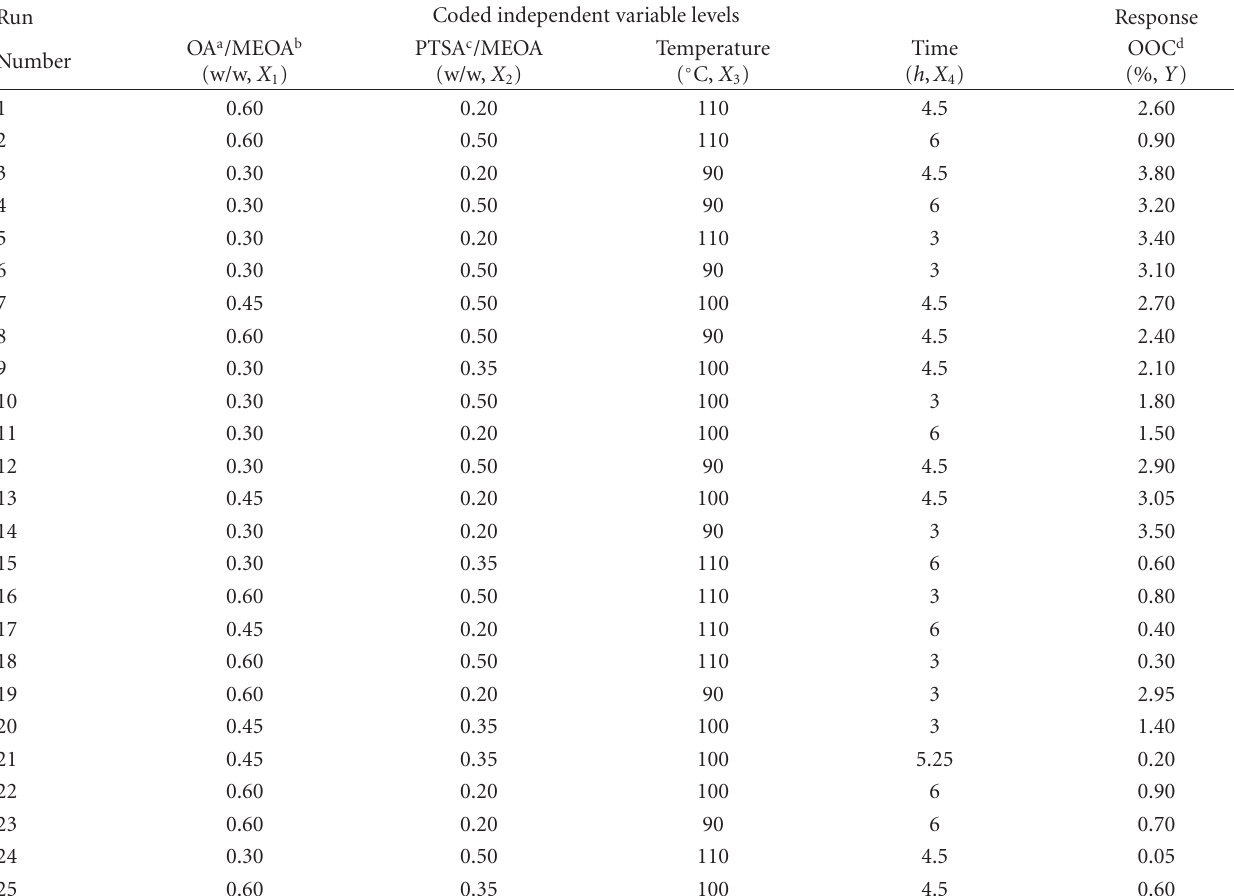
Table 2: D-optimal design arrangement and OOC% response of